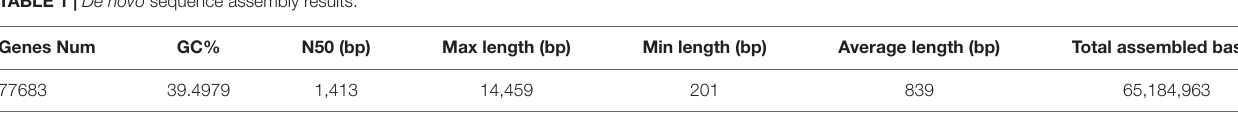
TABLE 1 | De novo sequence assembly